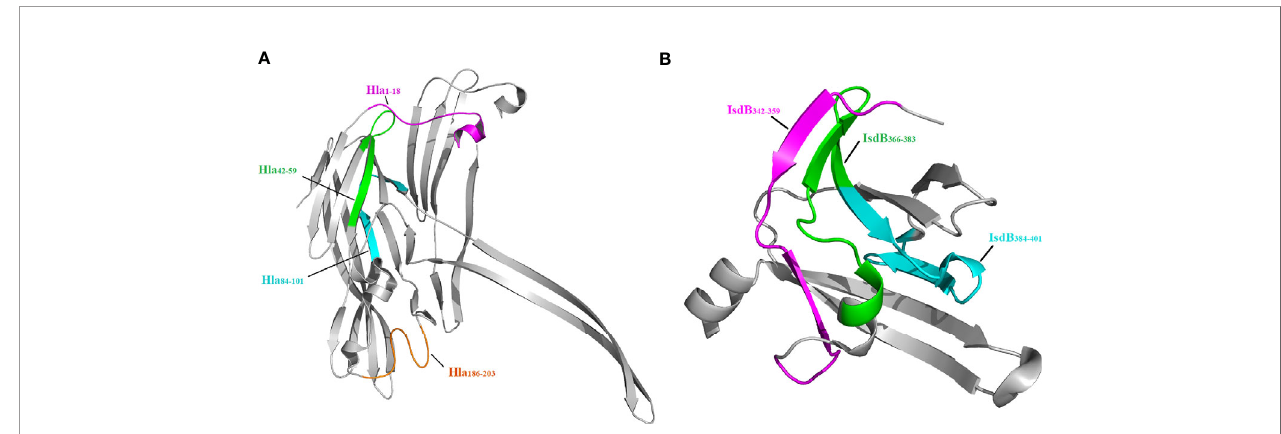
FIGURE 4 | Localization of immunodominant epitopes on Hla and IsdB. The crystal structures of Hla (3anz.pdb) and IsdB (3rtl.pdb) were obtained from PDB. Immunodominant epitopes of Hla (A) and IsdB (B) were located on these structures using the PyMOL 1.1